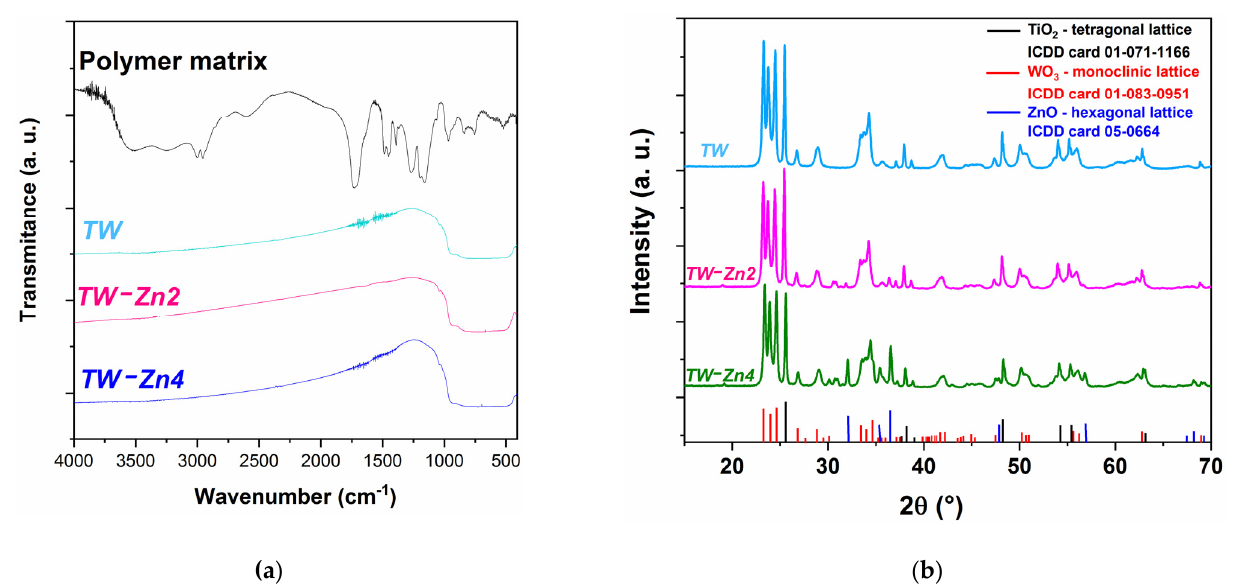
Figure 4. ( a ) FTIR spectra and ( b ) X-ray diffractograms of the TW , TW − Zn 2, and TW − Zn 4 MOHN . Table 1. Lattice parameters and crystallite size of TiO 2 in TW , TW − Zn 2 and TW − Zn 4 MOHN . Lattice Parameters (Å) Average Crystallite Size, D